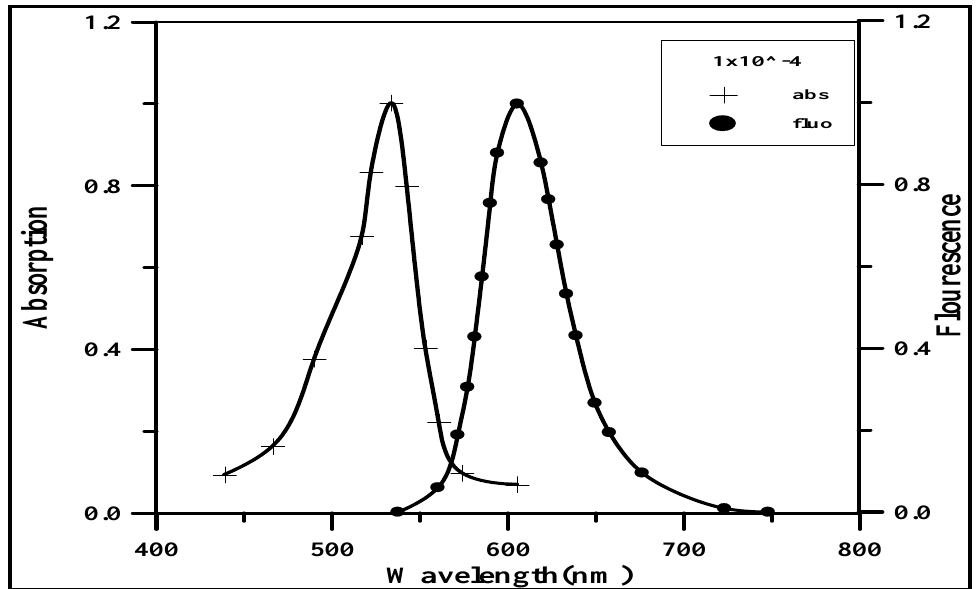
Fig.5: The absorption and fluorescence spectrum of R6G dye doped PMMA for concentration 1×10 -4 mol/ ℓ at thickness